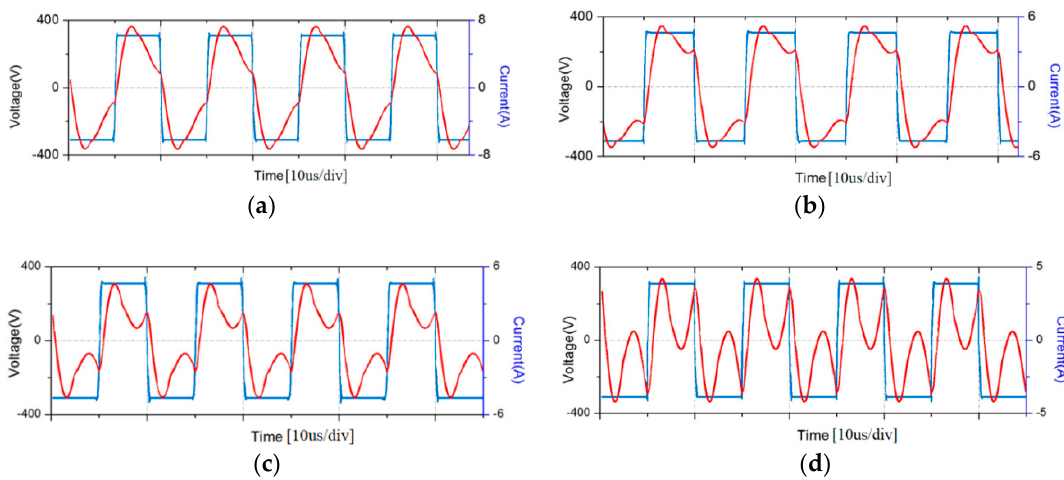
Figure 12. Inverter output voltage and current waveform under different coupling factors: ( a ) k = 0.52; ( b ) k = 0.61; ( c ) k = 0.71; ( d ) k = 0.82. Table 1. Component third harmonic as a variation of coupling coefficient.